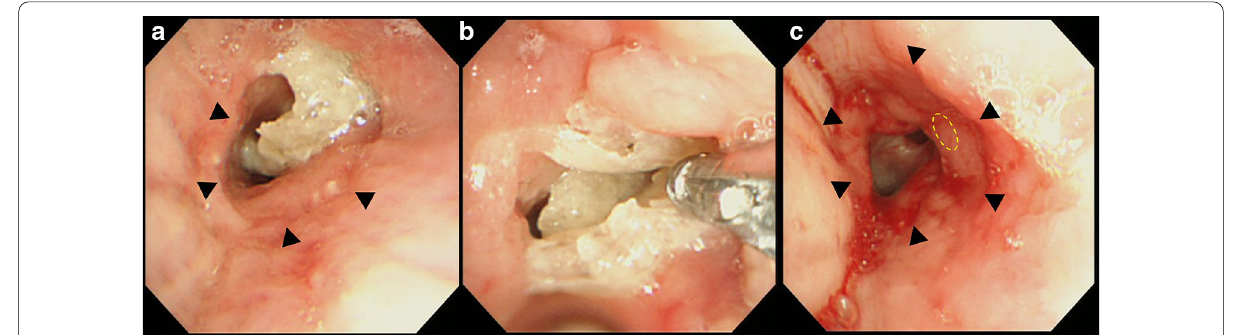
Fig. 1 Bronchoscopic images. a Left main bronchus. The anastomosis of the previous transplantation (black arrowheads) and a white foreign body distal to the anastomosis are shown. b The foreign body was removed by bronchoscopic biopsy forceps. c The left main bronchus after removal of the foreign body. The granulation tissue around the fistula is indicated as yellow dotted line and the bronchial anastomosis is indicated as black